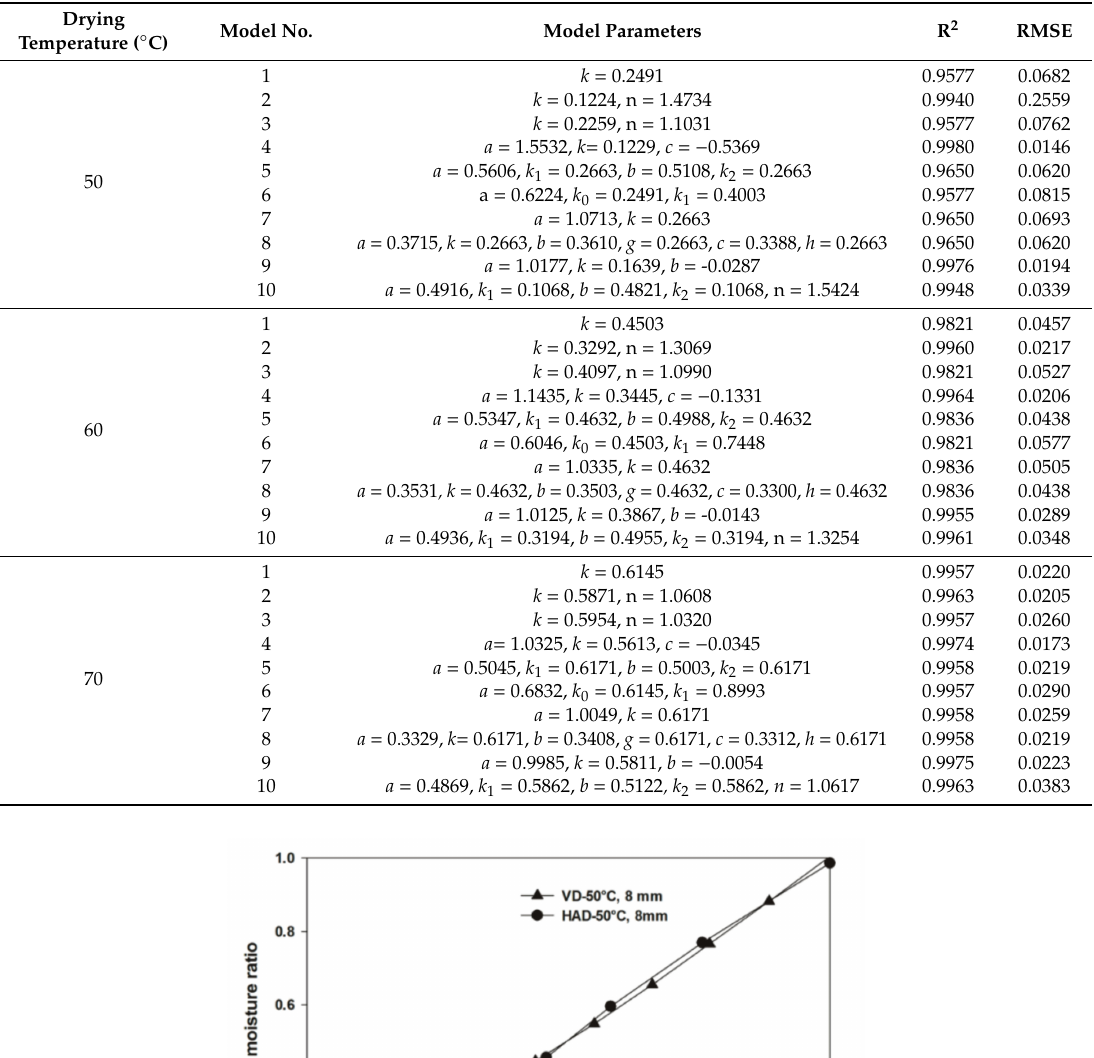
Table 4. Statistical evaluation of the mathematical drying models for persimmon samples of 5 mm thickness for VD.